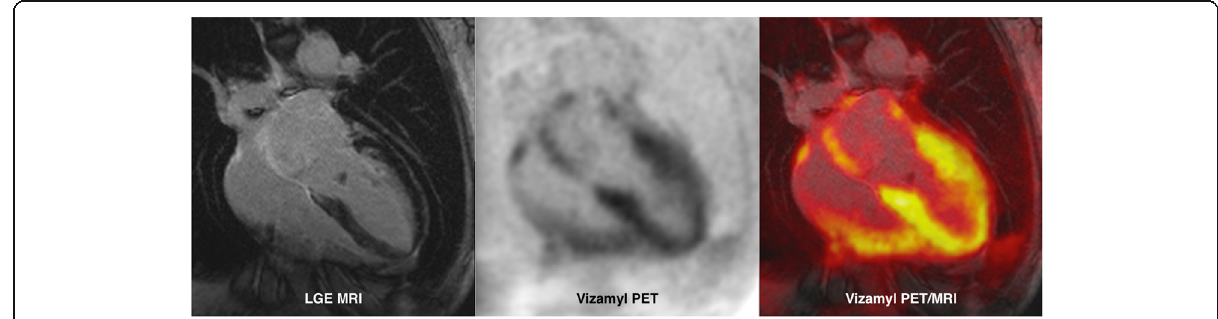
Fig. 2 Cardiac amyloid PET/MRI of a patient with hereditary ATTR amyloidosis (case 2): Late gadolinium enhancement (LGE) MRI demonstrates a thickened septal wall, diffuse LGE of the ventricular walls and contrast enhancement of the atria (left panel). On F-18 flutemetamol (Vizamyl) PET scan, moderate to intense tracer accumulation in the right and left ventricular walls as well as in the atria was observed (middle panel). The right panel demonstrates the overlay of amyloid PET and LGE